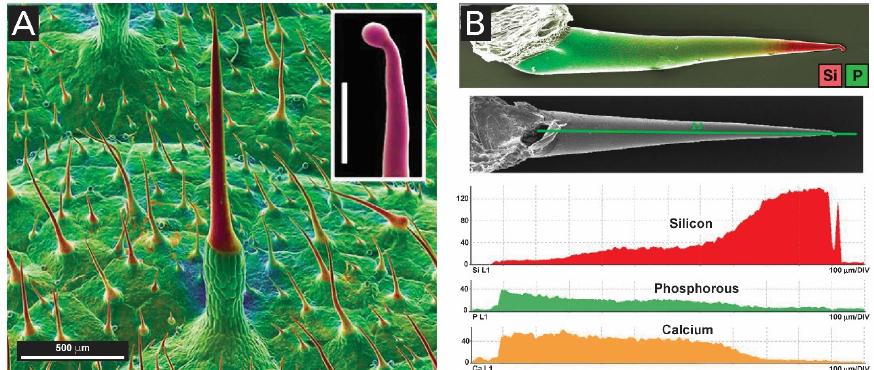
Figure 19. Morphology and composition of stinging hairs of Urticaceae . ( A ) Cryo-SEM micrographs of typical stinging hairs on leaves of Urtica dioica . Insert: silicified bulbous tip of stinging hair (red: high silicon content; green: organic compounds only; scale bars: 50 μ m). ( B ) Element-mapping images. Line scans display concentration profiles from tip to base (green scale bar: 300 μ m). Adapted from [130] with permission from John Wiley and Sons.